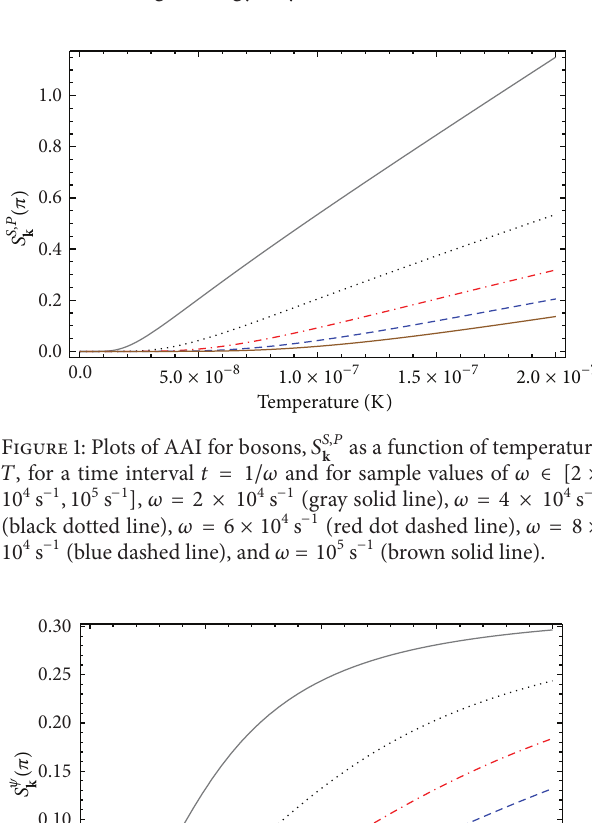
Figure 2: Plots of AAI for fermions, 𝑆 𝑇 , for the same time interval and sample values of 𝜔 as in Figure